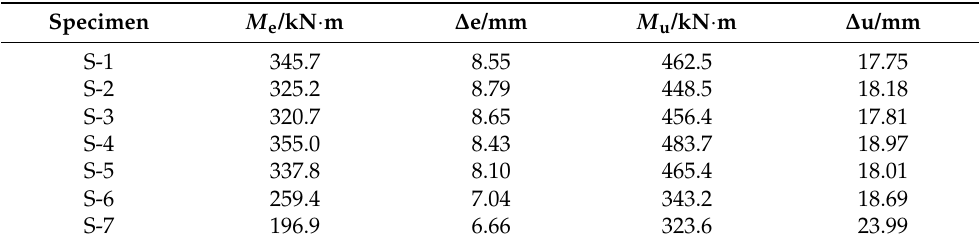
Table 4. Moment capacities and the corresponding